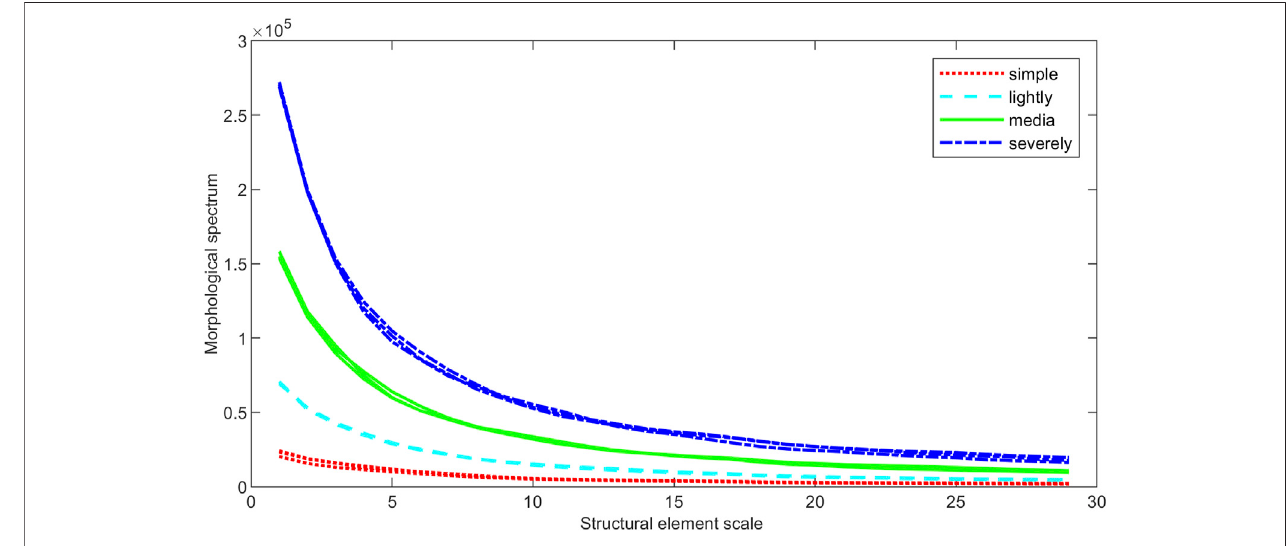
FIGURE 7 | MGS analysis result of diamond SE.